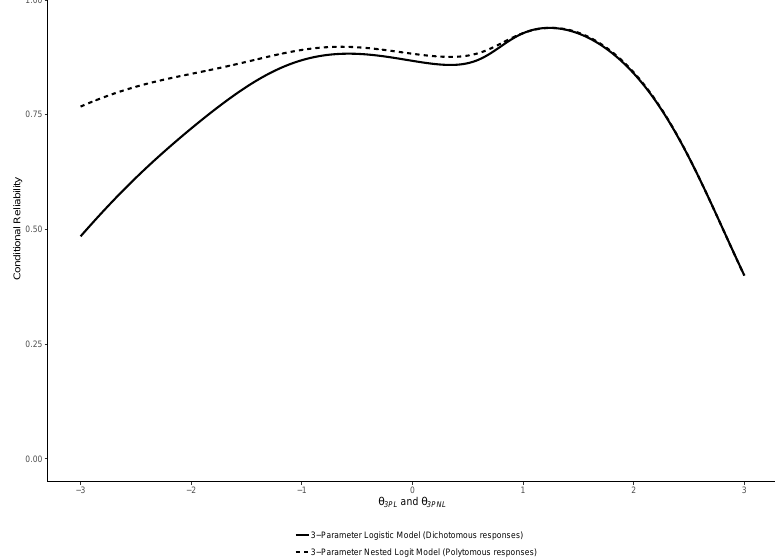
Figure 9. Comparison of the reliability functions of the 3-Parameter Logistic (3PL) and Nested Logit (3PNL)